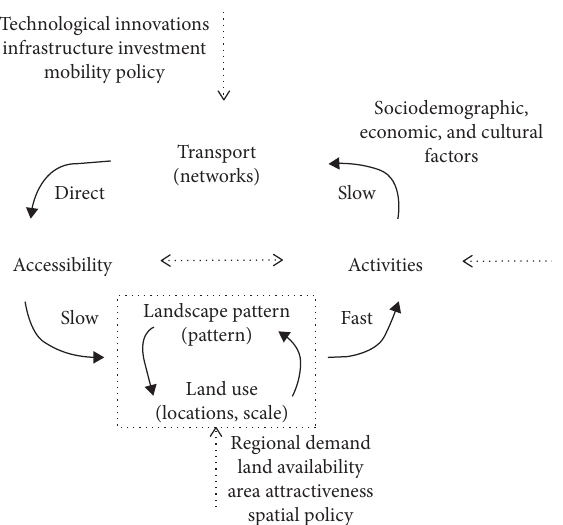
Figure 4: Influence mechanism of accessibility on land use and landscape pattern